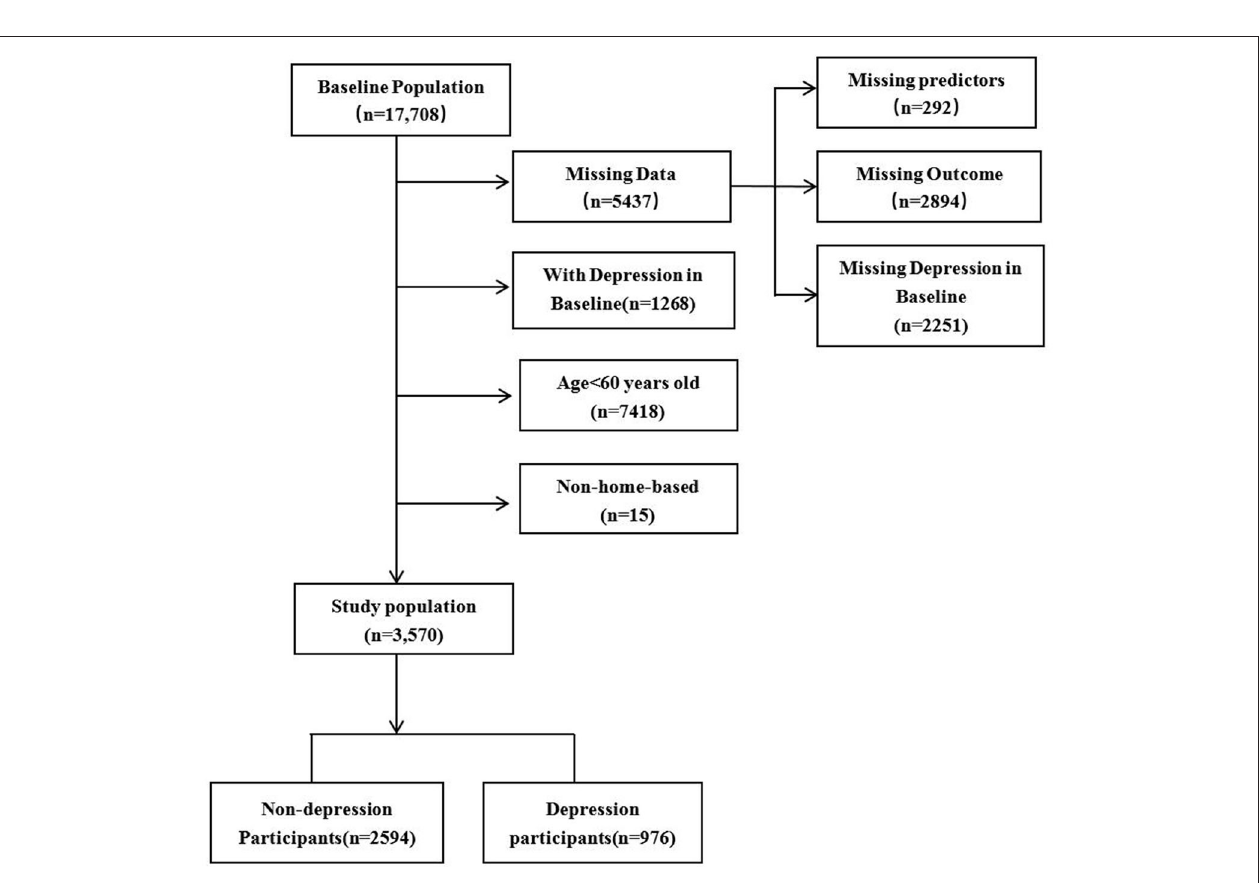
FIGURE 2 | A flow chart for study population